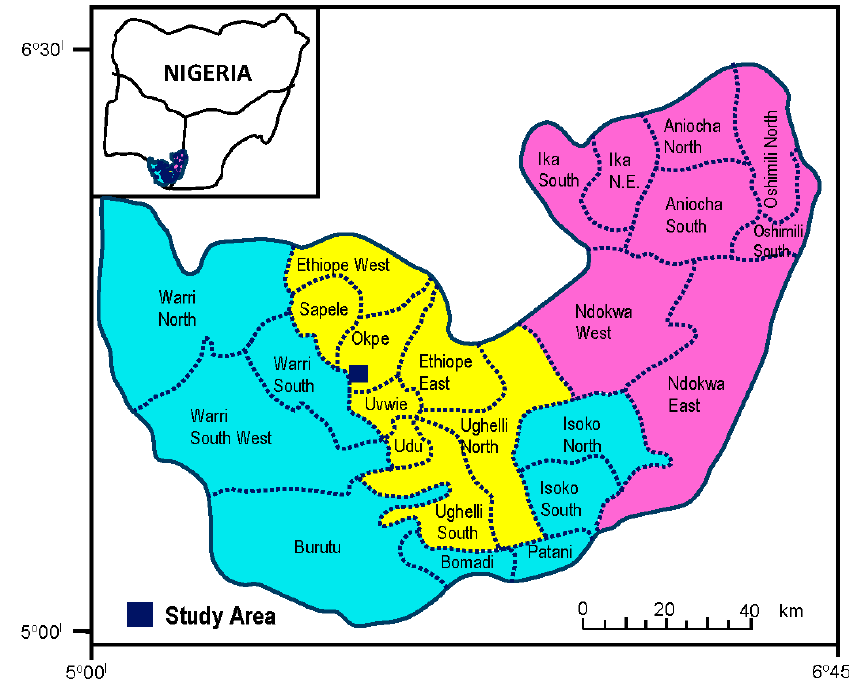
Figure 1. Map of Delta State showing the study area.